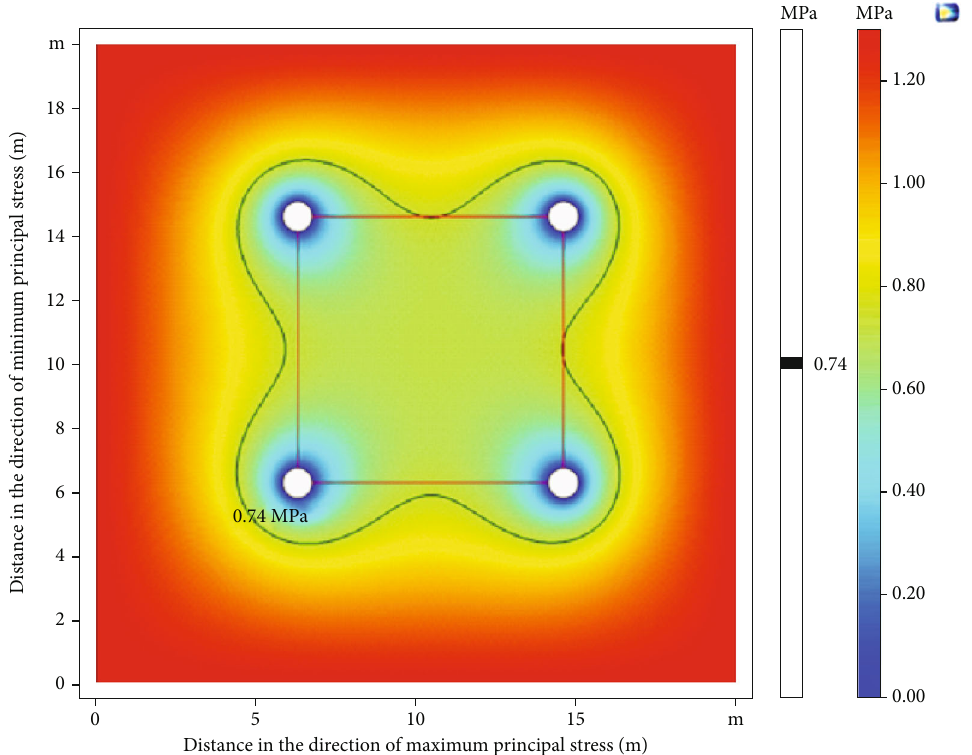
Figure 11: Gas stress distribution map of the holes that are equivalent to a cylinder.